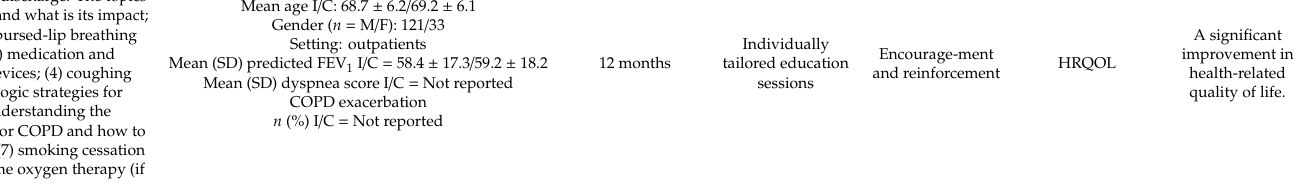
COPD education and teaching Motivational